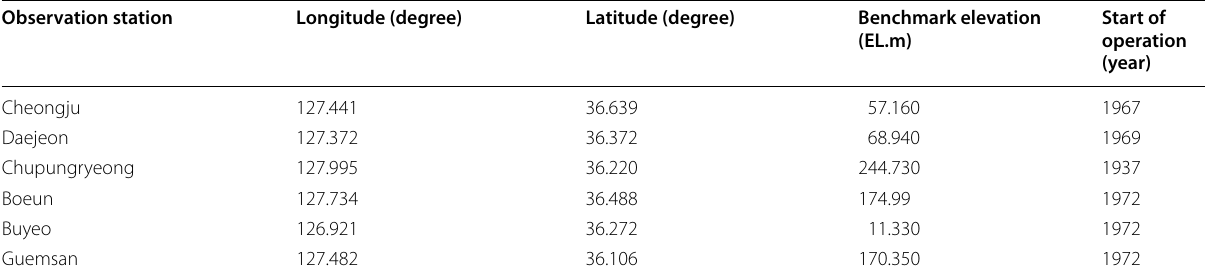
Table 1 Specifications of the observation weather station included in the study Observation station Longitude (degree) Latitude (degree) Benchmark elevation